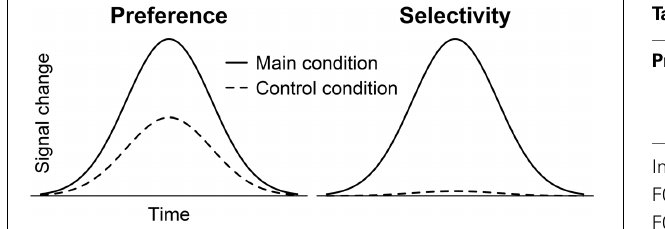
FIGURE 1 | BOLD time courses showing preferential vs. selective activation depending on the amplitude elicited by a control condition. Provided the main condition induced the larger amplitude, the control condition could evoke significant activation as well (preference) or fail to raise the activation above a resting baseline level (selectivity).